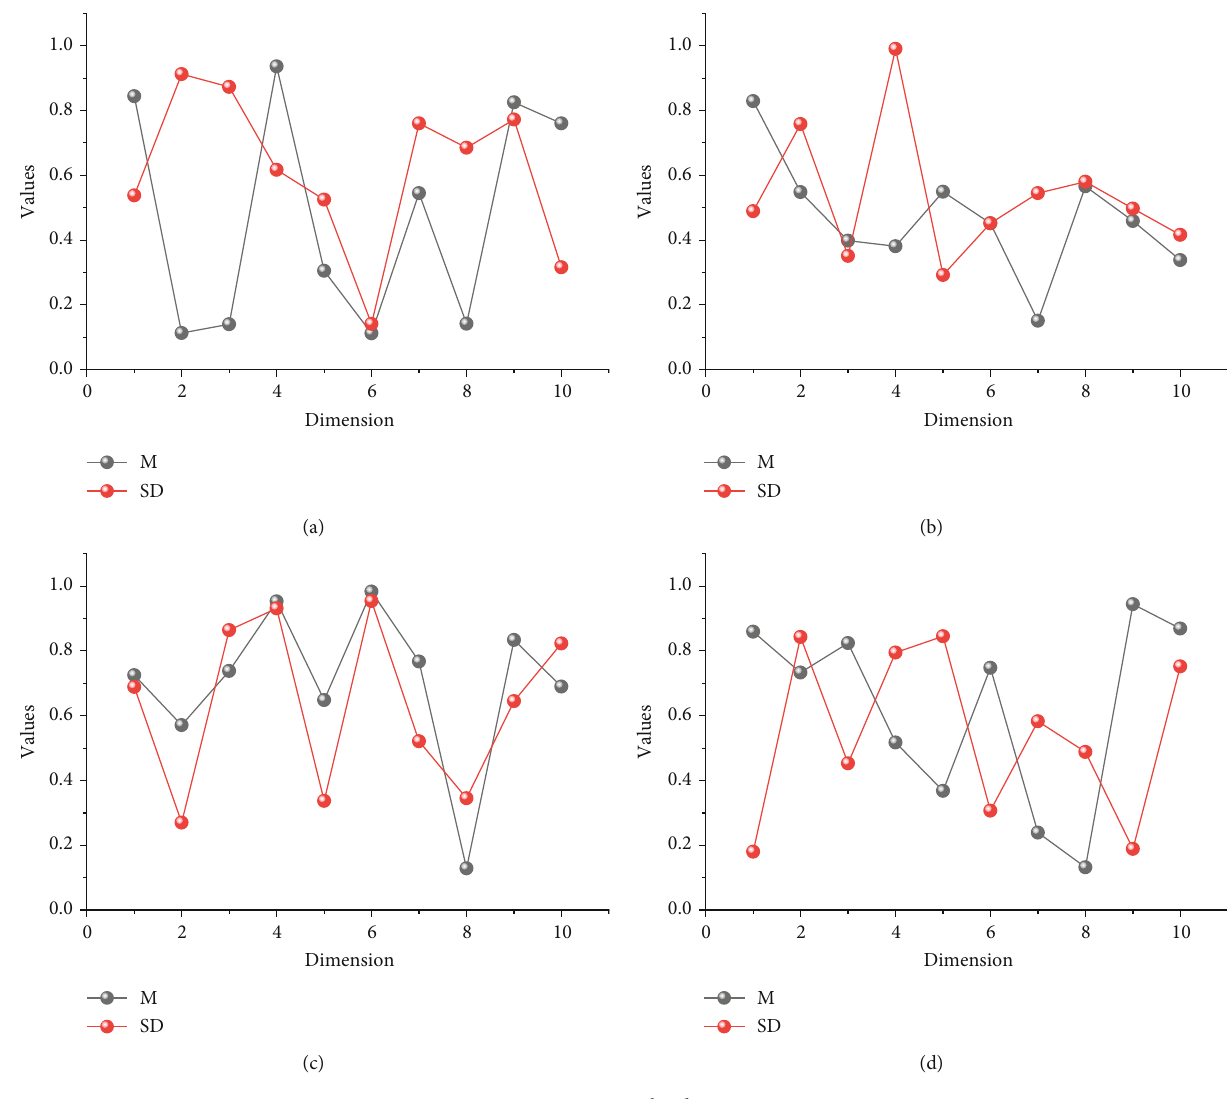
Figure 7: Situation by